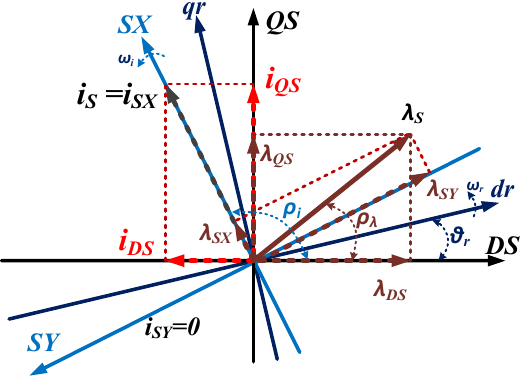
Figure 1. Relationship of spatial ( X-Y ) and stationary ( D S -Q S ) reference frames.